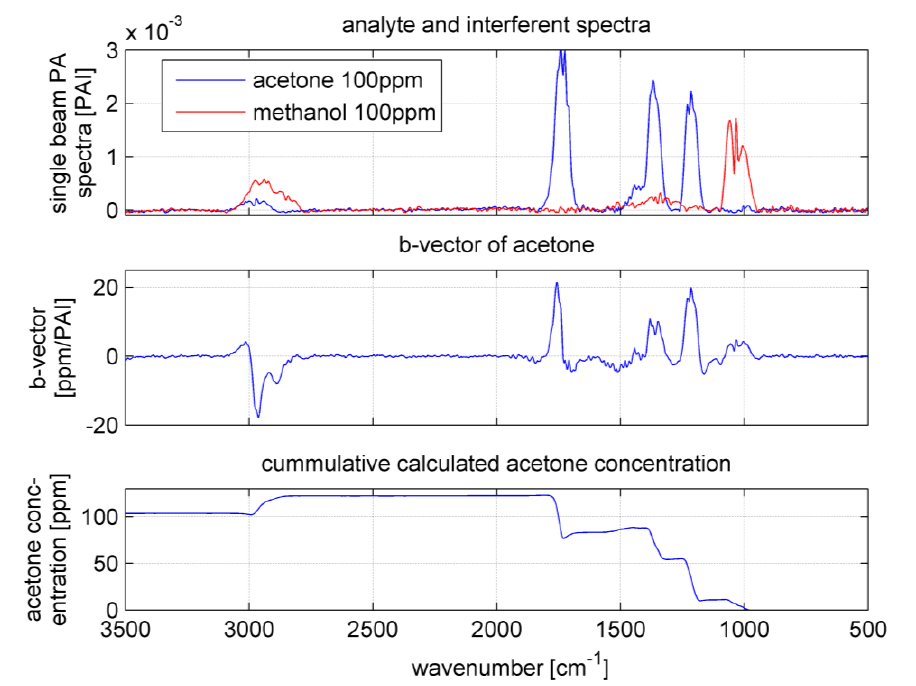
Figure 7. Sample spectrum, b-vector and result calculation: A schematic demonstration. The upper graph shows the sample spectrum (analyte and interferent spectra plotted separate), in the middle the b-vector for the analyte acetone and the lower graph the resulting cumulative sum of the vector multiplication of b-vector and sample spectrum (accumulation starts from 500 cm −1